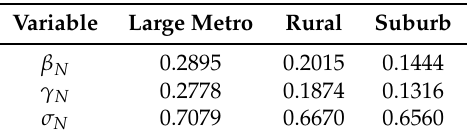
Table 2. Parameter estimation of the non-injection drug users reduced MRSA model given in [14] using regional data.